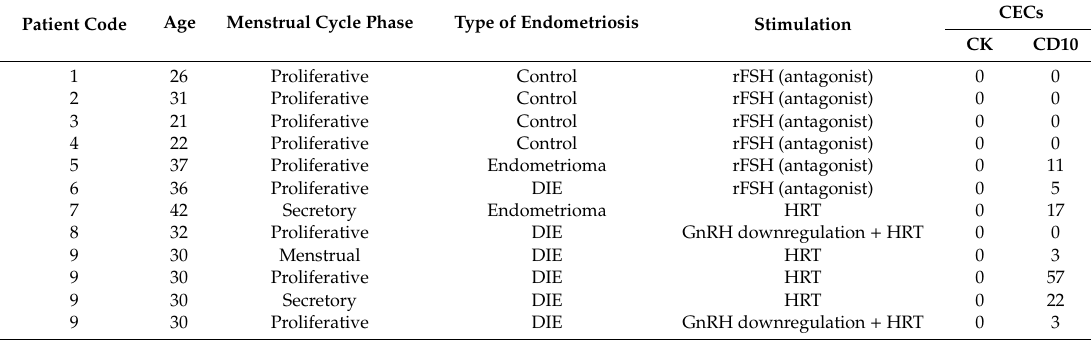
Table 1. Patient characteristics and number of circulating endometrial cells in each